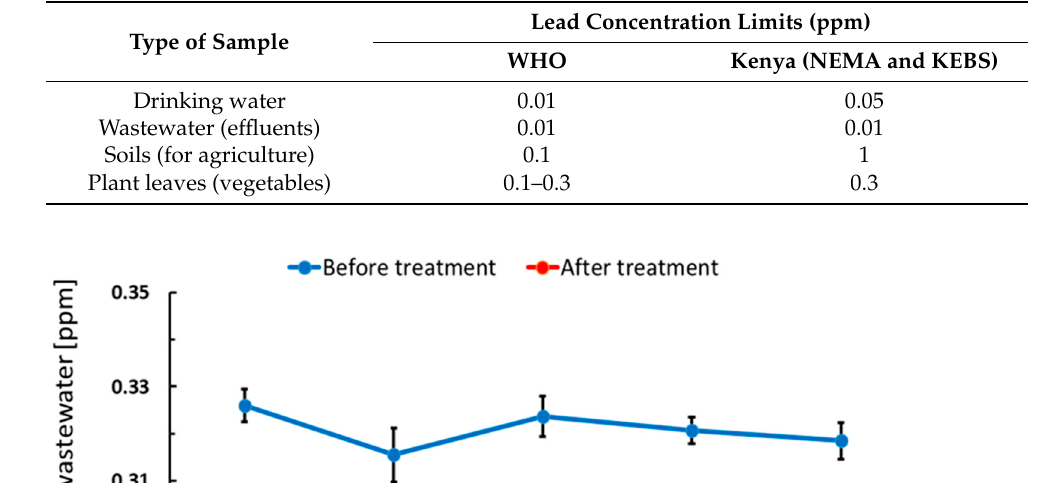
Table 1. Limits of selected heavy metals (ppm) in drinking water, wastewater, soils and vegetables as recommended by WHO and Kenya (NEMA and KEBS) (arranged from [13]).